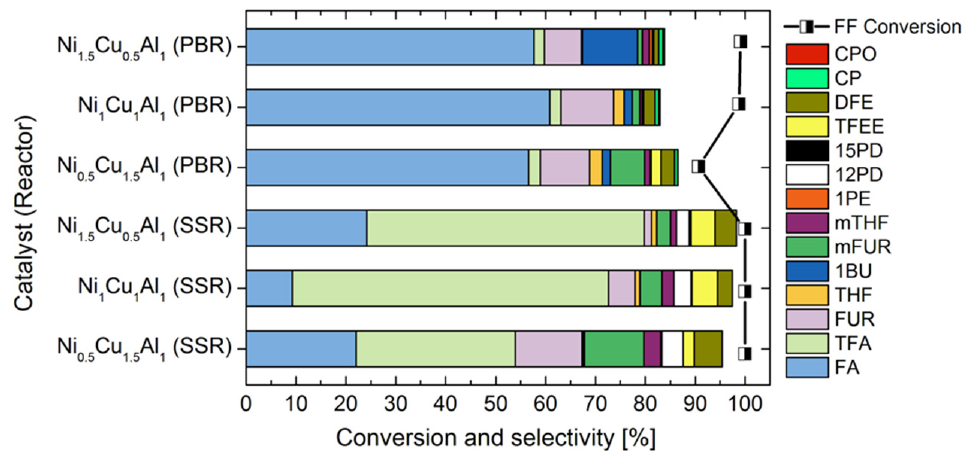
Figure 6. Furfural conversion and product selectivity of the three catalysts in an atmospheric PBR and an SSR at 5.0 MPa H 2 . All experiments were performed at 463 K. Tetrahydrofurfuryl alcohol (TFA) was the main product obtained on Ni 1 Cu 1 Al 1 -R, with a selectivity of 63%, together with furfuryl alcohol (FA 9.2%), furan (FUR 5.3%), 2- methylfuran (mFUR 4.3%), 2-methyltetrahydrofuran (mTHF 2.4%) and 1,2-pentanediol (12PD 3.4%). In addition, two products that could not be formed by direct hydrogena- tion/hydrogenolysis of furfural were present: ethyl tetrahydrofurfuryl ether (TFEE 5.2%) and difurfuryl ether (DFE 3.0%). Shifting to a higher copper content (Ni 0.5 Cu 1.5 Al 1 -R) reduced the formation of TFA to 32% and enhanced the selectivity to FA (22%), FUR (14%), mFUR (12%), 12PD (4.3%) and mTHF (3.3%). However, on Ni 1.5 Cu 0.5 Al 1 -R, the selectivity to TFA declined (56%), while that of FA increased (24%), and the formation of FUR, mFUR, 12PD and mTHF was lower than that on Ni 1 Cu 1 Al 1 -R. Trace amounts of 1-butanol (1BU) and 1,5-pentaneanediol (15PD) and significant amounts of TFEE and DFE were always formed with the Ni/Cu atomic ratio, shifting selectivity towards more TFEE and less DFE. Three competing pathways were involved in the conversion of FF in the SSR (Scheme